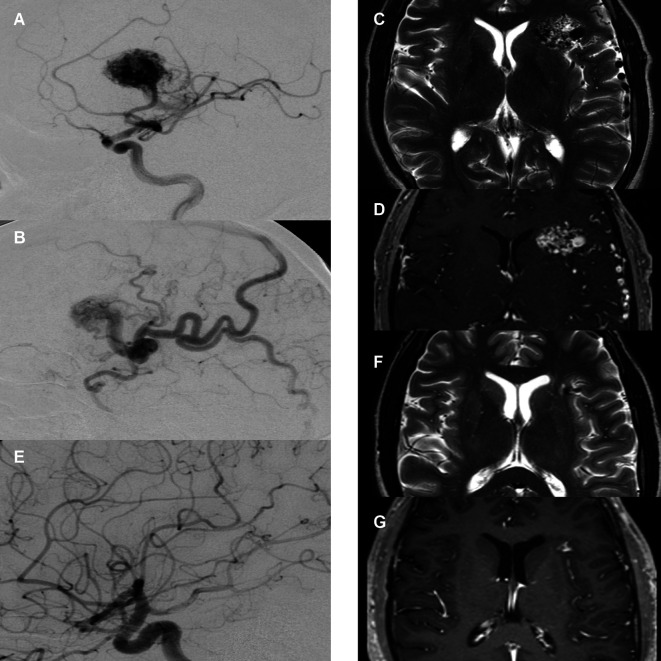
Case illustration. (A) Pre-treatment digital subtraction angiography (DSA), lateral view, arterial phase. Depiction of right frontal arteriovenous malformation (AVM) supplied by the medial cerebral artery with large nidus. (B) Pre-treatment DSA, lateral view, early venous phase. Depiction of diluted cortical veins. (C) Pre-treatment T2-sequence magnetic resonance imaging (MRI) with depiction of AVM nidus and diluted veins. (D) Pre-treatment T1-MR-angiography of the same area. (E) 2-year post-treatment follow-up DSA, arterial phase with no residual nidus or early venous drainage. (F) 2-year post-treatment follow-up T2-sequence MRI with depiction of a small residual lesion without T2-hyperintense radiation induced changes. (G) 2-year post-treatment follow-up T1-MR-angiography with depiction of small residual contrast enhancement.